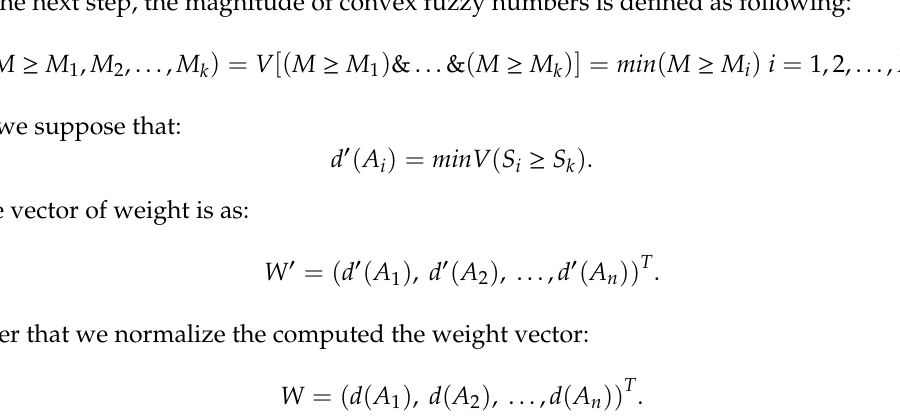
Figure 3. Interference between M 1 and M 2.